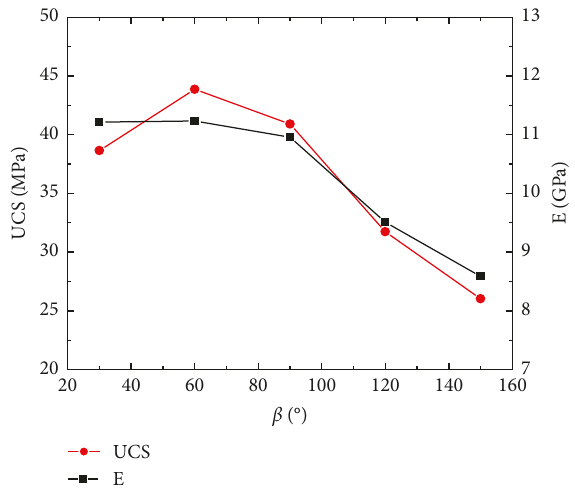
Figure 5: UCS and E of rocks with different joint cross-angles.